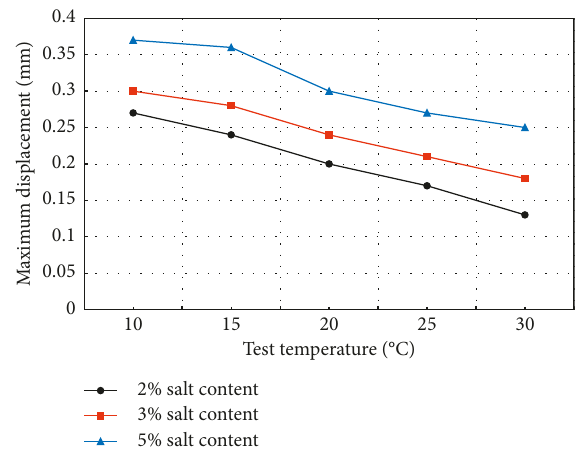
Figure 6: Maximum salt expansion displacement corresponding to temperature and salinity.